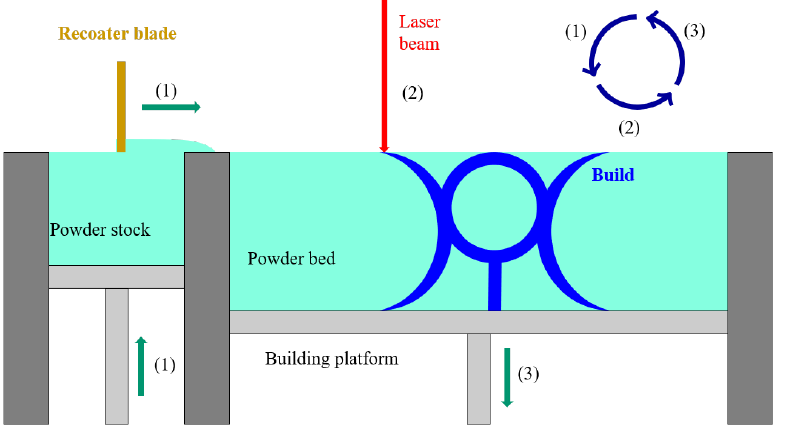
Figure 1. Schematic drawing of the workflow of the typical SLM process where the part shape is not fixed.